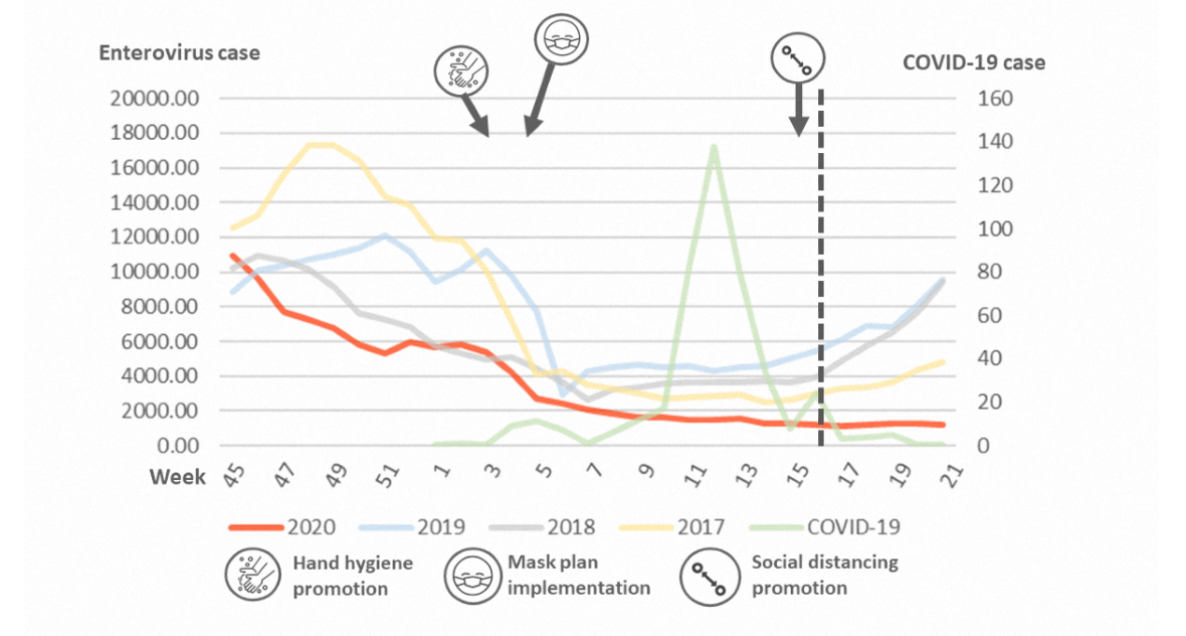
Figure 4. Incidences of enterovirus in 2017-2020. Dotted line marks the increase that is usually seen in enterovirus infection cases in week 16, although this was not observed in 2020. COVID-19: coronavirus